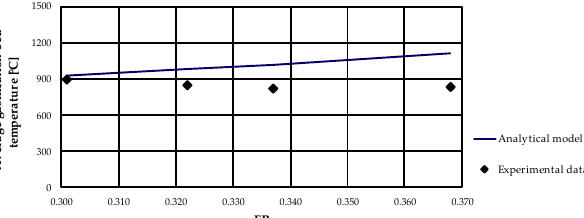
Figure 9. Comparison of average gasification bed temperature between analytical model results and experimental data from coniferous wood [69]. Table 4. Comparison of syngas mole fraction composition between the results of analytical and Aspen models and experimental data from wood pellet gasification [36].